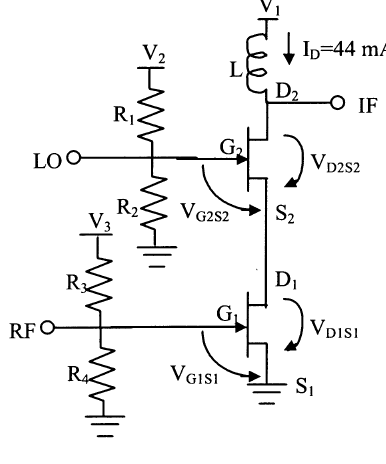
FIGURE 8 DC biased circuit.